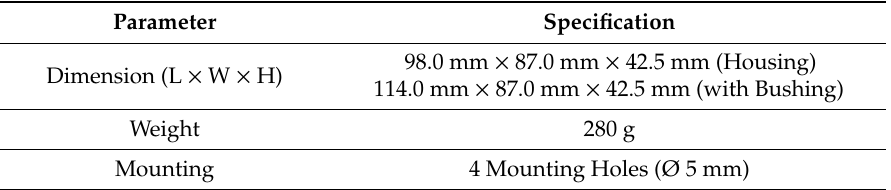
Table 2. Hardware: Housing